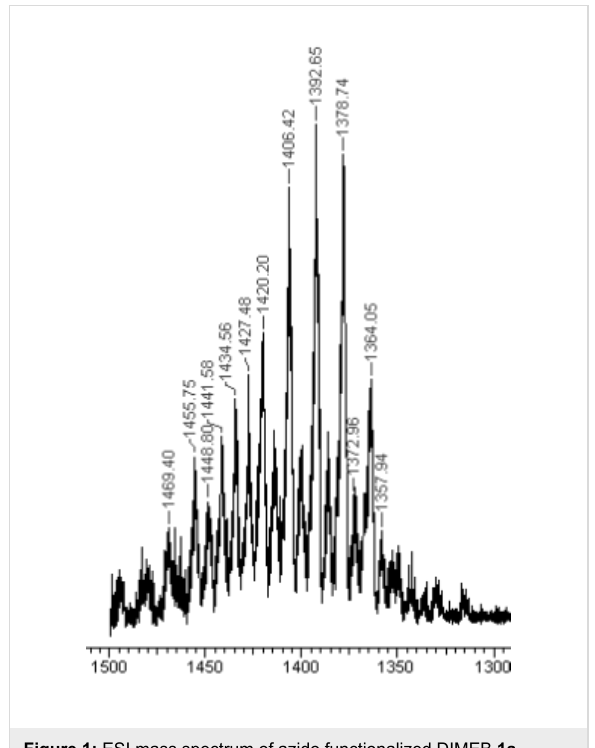
Figure 1: ESI mass spectrum of azido functionalized DIMEB 1a .